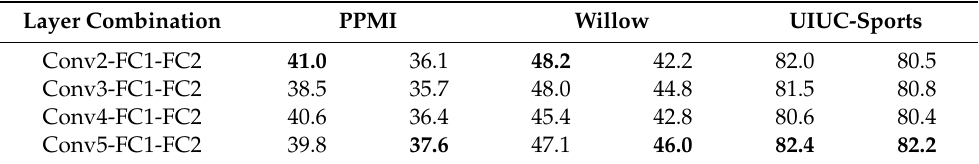
Table 6. Classification accuracy (%) of the ASL network. For each dataset, the first column is the teacher network and the second column is the student network. Three layers of the teacher network are bound to Conv3, FC1, and FC2 layers in the student network.